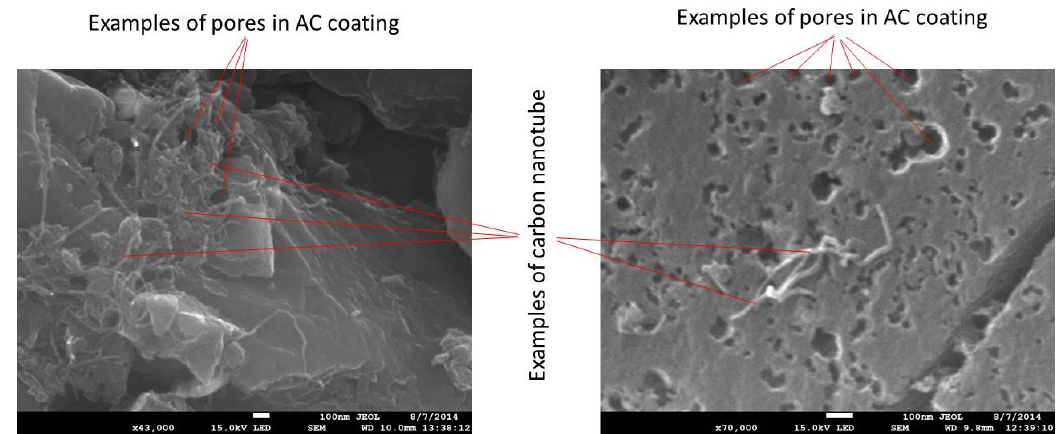
Figure 3. HR-SEM images of a composite coating from this study at different magnifications; scale bar = 100 nm.